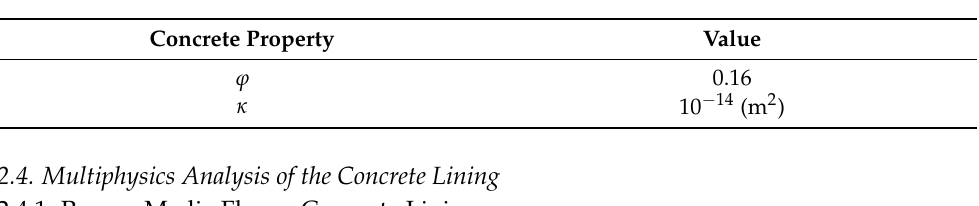
Figure 8. Stress–strain curves of various concrete types as a function of temperature [18]. Table 2. Porosity and permeability properties of concrete used in COMSOL calculations